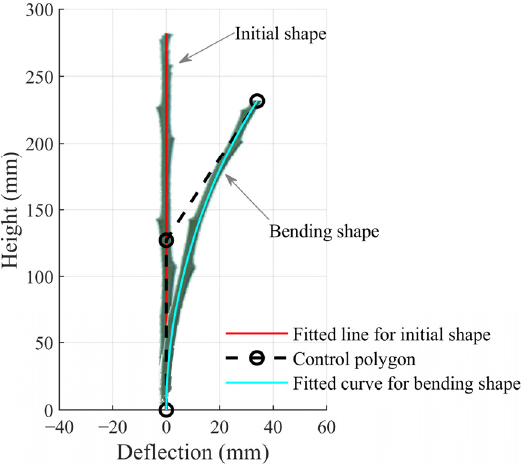
Figure 4. An example of curve fitting for tea stalk.